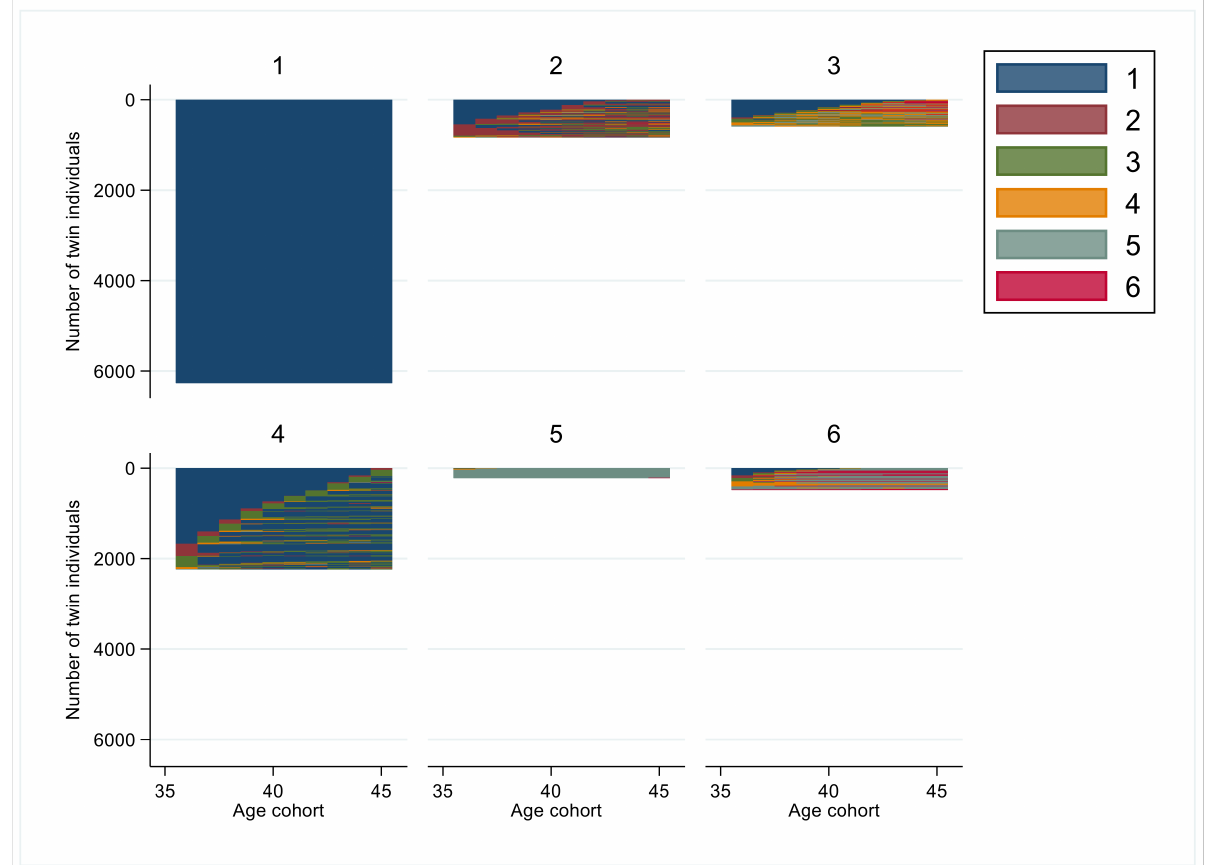
Figure 2. Cluster groups of sequences of interruptions in working life among the age co- hort 36–45 years. (Code for colors: 1. sustainable working life : SA/DP 0–30 days and UE 0–90 days; 2. Unemployment > 90 days : SA/DP 0–30 days and UE > 90 days; 3. Moderate SA/DP : SA/DP 30–180 days; 4. Almost full year of SA/DP : SA/DP 180–365 days; 5. Full year of SA/DP : SA/DP ≥ 365 days; 6. Death